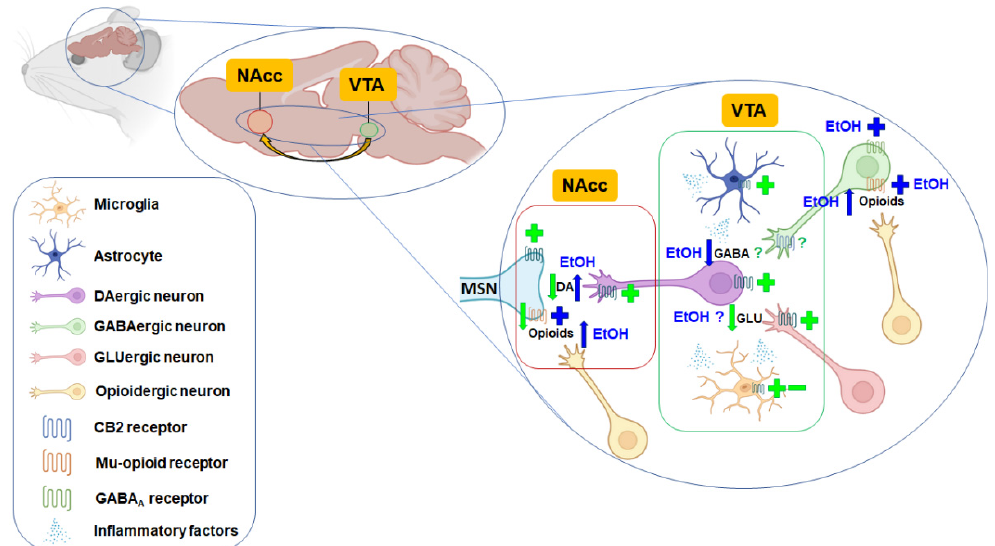
Figure 1. Graphic diagram illustrating the proposed mechanisms involved in ethanol actions (blue) and CB 2 r-mediated regulation of the mesolimbic DA system (green) according to studies performed in rodents. Ethanol increases the release of dopamine in the nucleus accumbens (NAcc) mainly by increasing the release of endogenous opioids acting on mu-opioid receptors and inhibiting GABAergic neurotransmission. The activation of CB 2 r induces different actions depending on its location: (1) reduction of dopamine (DA) release from ventral tegmental area (VTA) DAergic neurons projecting to the NAcc; (2) reduction of glutamate (GLU) release from GLUergic neurons projecting to VTA DAergic neurons; (3) modulation of inflammatory factors’ release from microglia or astrocytes, and (4) reduction of mu-opioid receptors density in the NAcc. According to available evidence, the role of CB2r in regulating GABA release from GABAergic terminals projecting to VTA DAergic neurons is not entirely clear. MSN: GABAergic inhibitory medium spiny neuron. Created with Biorender.com. +: activation/agonism; -: inhibition/antagonism; ↓ : reduction; ↑ : increase.